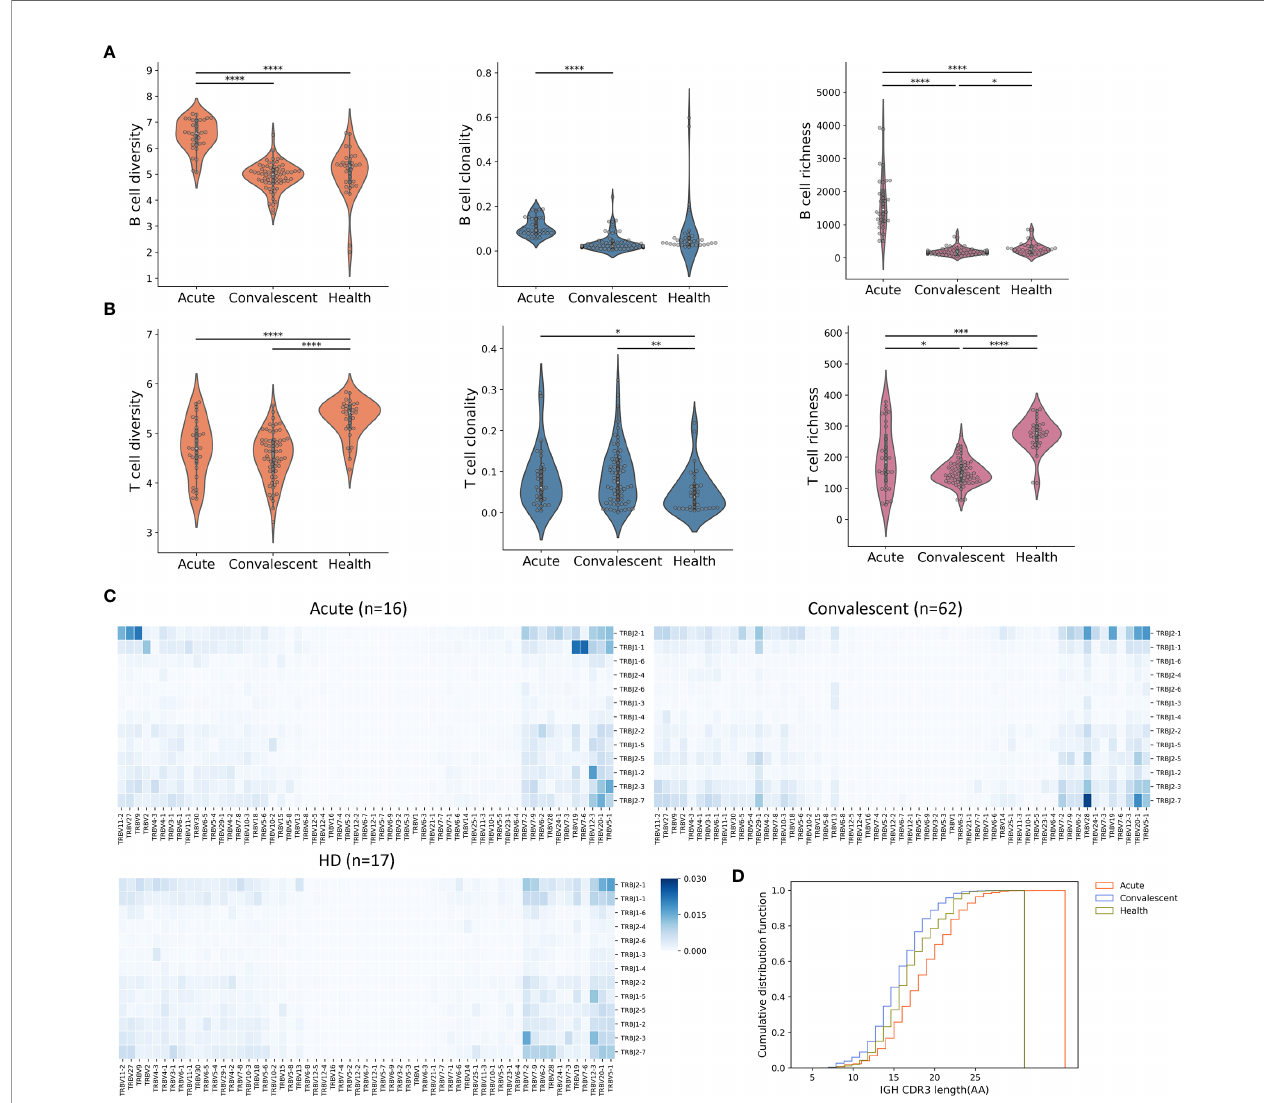
FIGURE 2 | Peripheral B-cell and T-cell diversity, richness, and clonality analyzed by RNA-seq. (A) The B-cell repertoire was characterized by diversity, richness, and clonality, as calculated on the basis of BCR sequence similarity including CDR3 sequence, as well as IGHV and IGHJ usage. * P < 0.05, ** P < 0.01, *** P < 0.001, **** P < 0.0001. (B) Characterization of peripheral T cells. (C) Heat maps showing T-cell V(D)J rearrangement in PBMC across three cohorts. The colors suggested the frequency of a particular V-J gene pair. (D) CDR3 length comparison of IGH. The acute patients seemed to have the maximum IGH CDR3 length, indicating frequent BCR